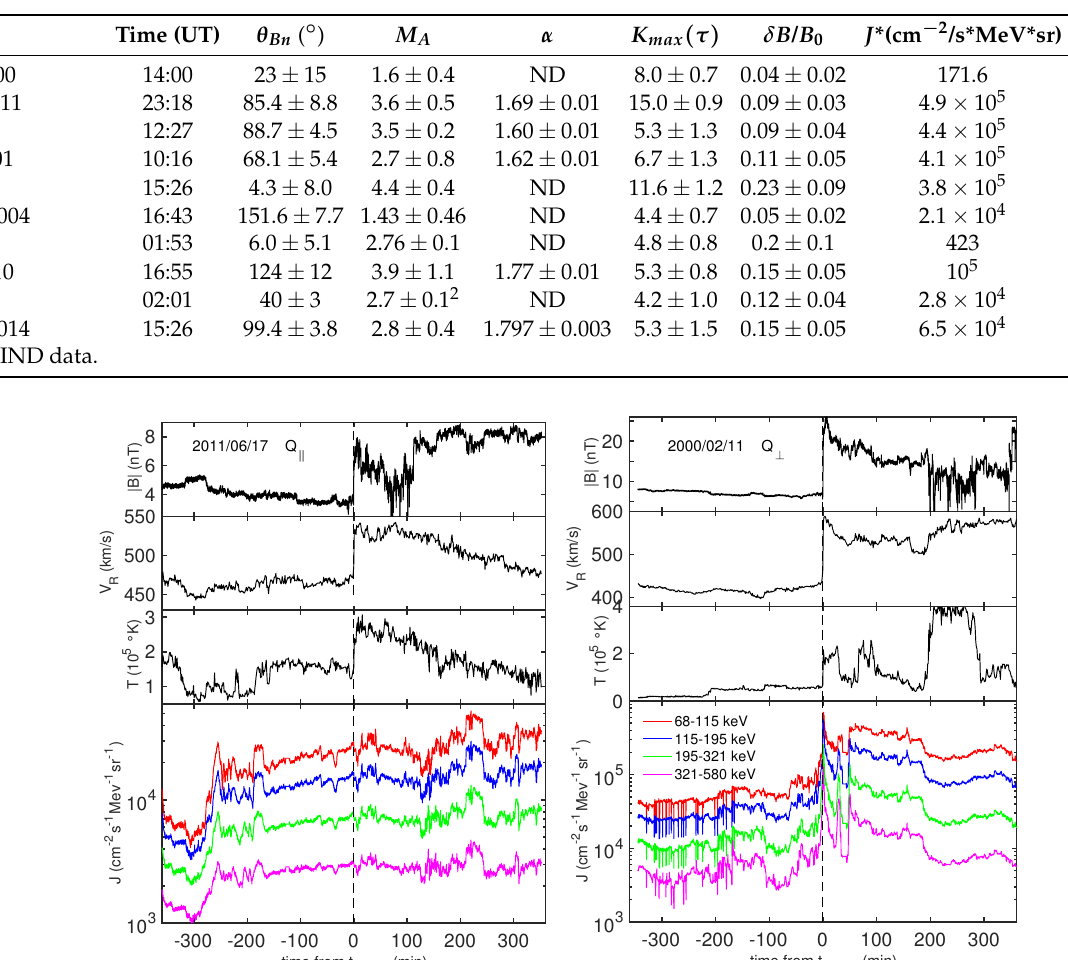
Table 1. Parameters of the ACE shock crossings analyzed: date of the events; time of the shock in UT; shock geometry; Alfvénic Mach number; the exponent of superdiffusion; the maximum value of the kurtosis at the Larmor scale of 100 keV protons; the fluctuation amplitude calculated at the scale of 100 keV protons; and the flux of the 100 keV protons at the shock.